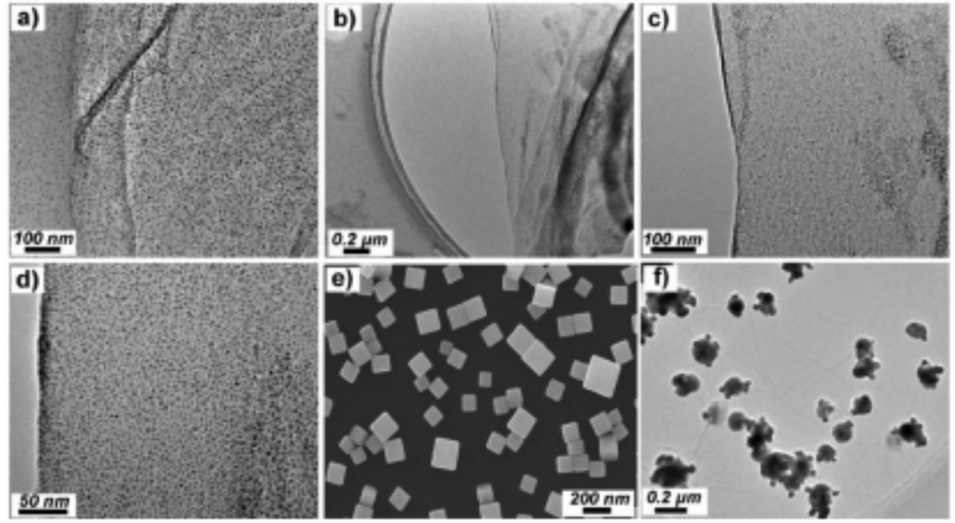
Figure 3. TEM images of Ag NPs: ( a ) Ag/AgCl/GO and ( b – d ) Ag/AgCl/rGO synthesized in the presence of GO and PDDA, ( e ) scanning electron microscope (SEM) images of Ag/AgCl synthesized in the presence of the PDDA surfactant, and ( f ) TEM image of Ag/AgCl/rGO synthesized without PDDA (adapted with permission from reference